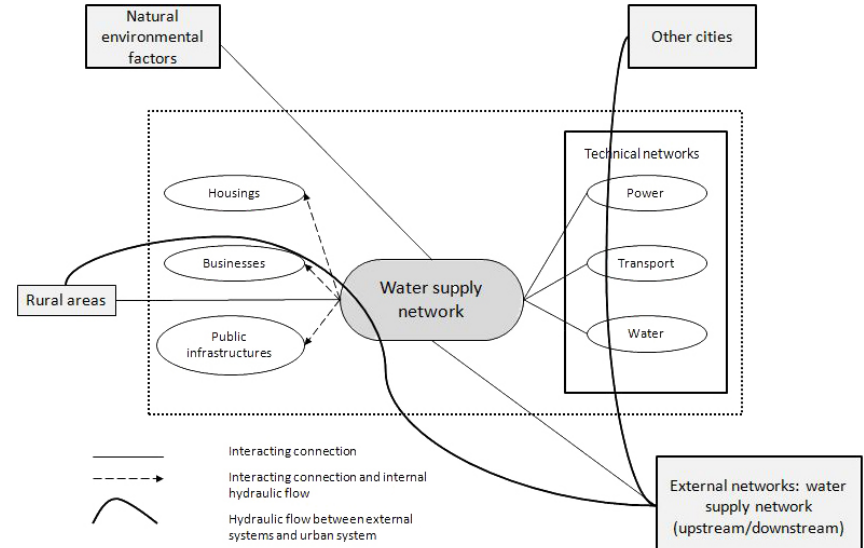
Figure 2. Functional block diagram for drinking water supply technical